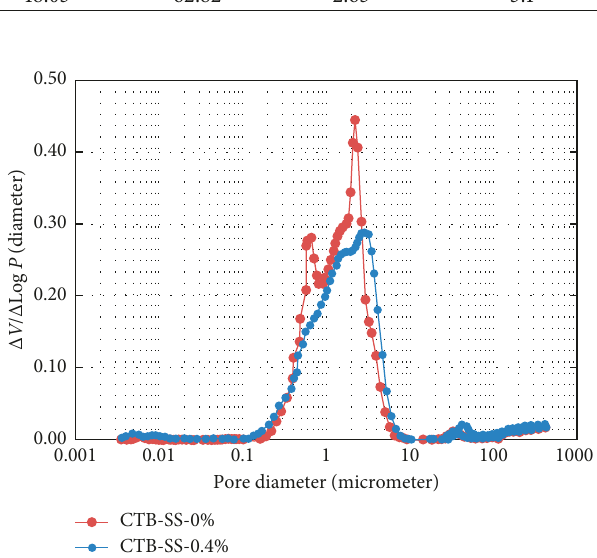
Figure 3: Differential pore size distribution curves of CTB that contain lead-zinc slag with SS and without SS.